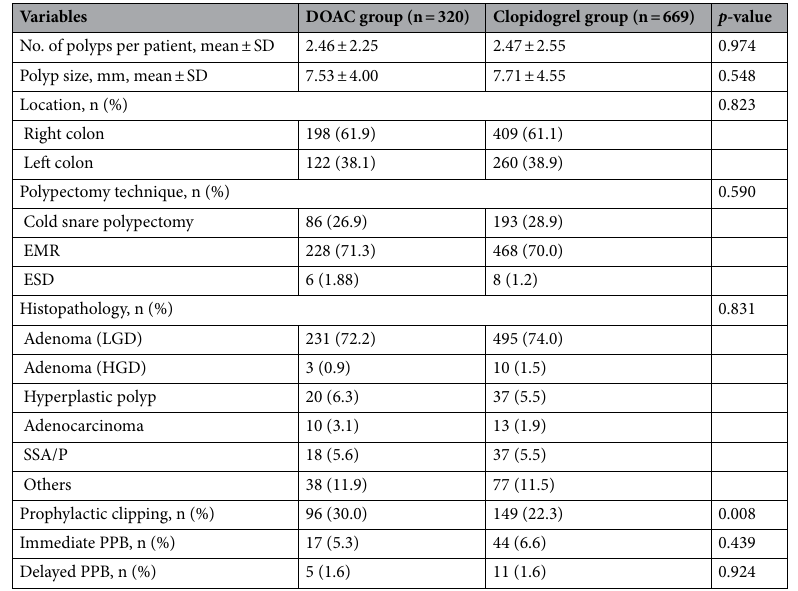
Table 2. Characteristics of the polyps and polypectomy procedure. DOAC Direct oral anticoagulant, EMR endoscopic mucosal resection, ESD endoscopic submucosal dissection, HGD high-grade dysplasia, LGD low- grade dysplasia, PPB postpolypectomy bleeding, SD standard deviation.